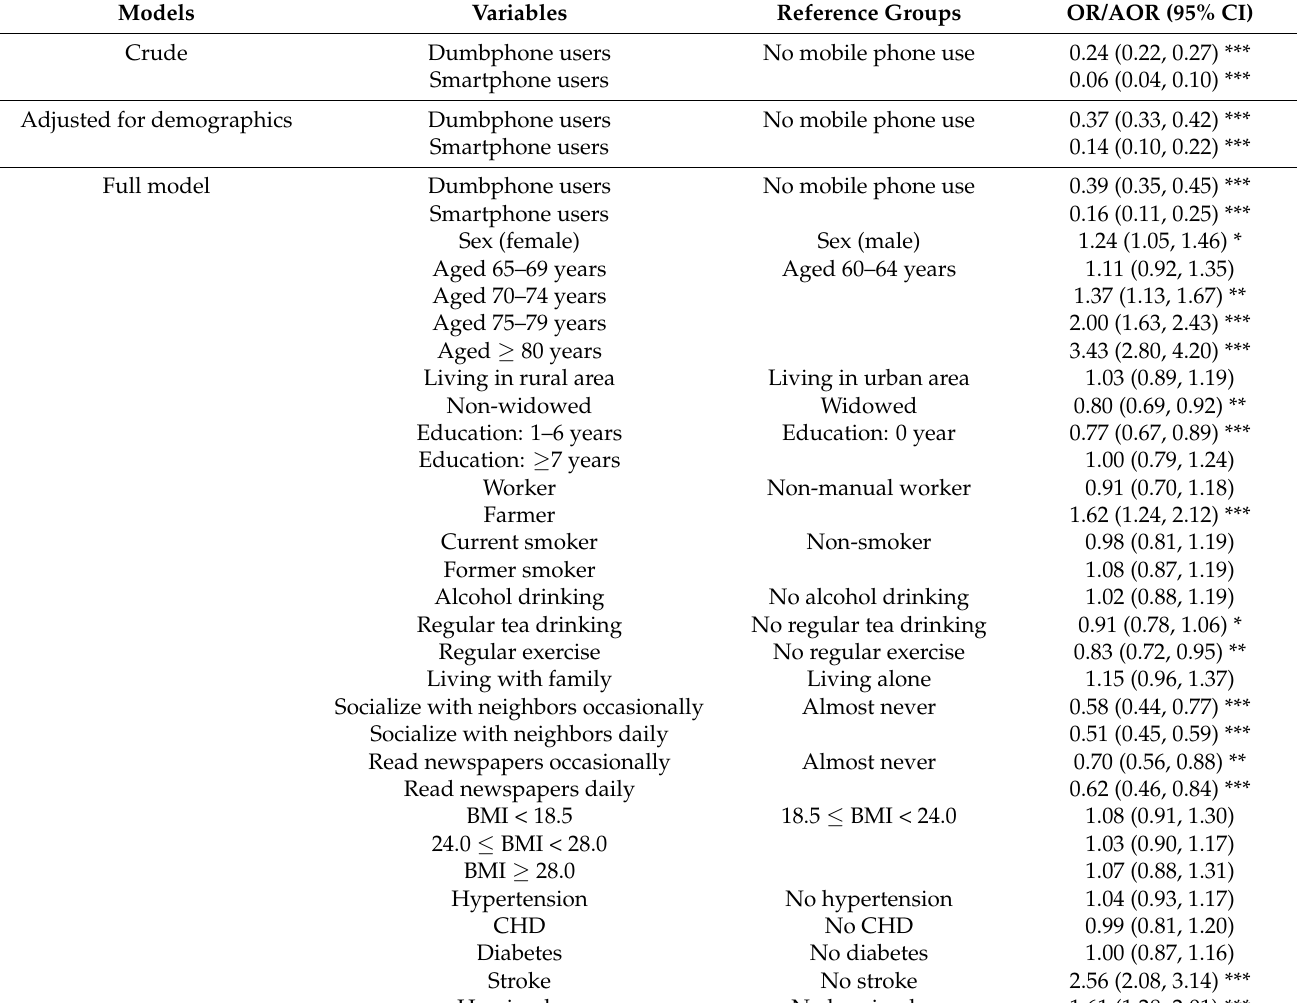
Table 2. Logistic regression analysis of cognitive impairment in people with different statuses of mobile phone use. Models Variables Reference Groups OR/AOR (95% CI) Crude Dumbphone users No mobile phone use 0.24 (0.22, 0.27) *** Smartphone users Adjusted for demographics Dumbphone users Smartphone users Full